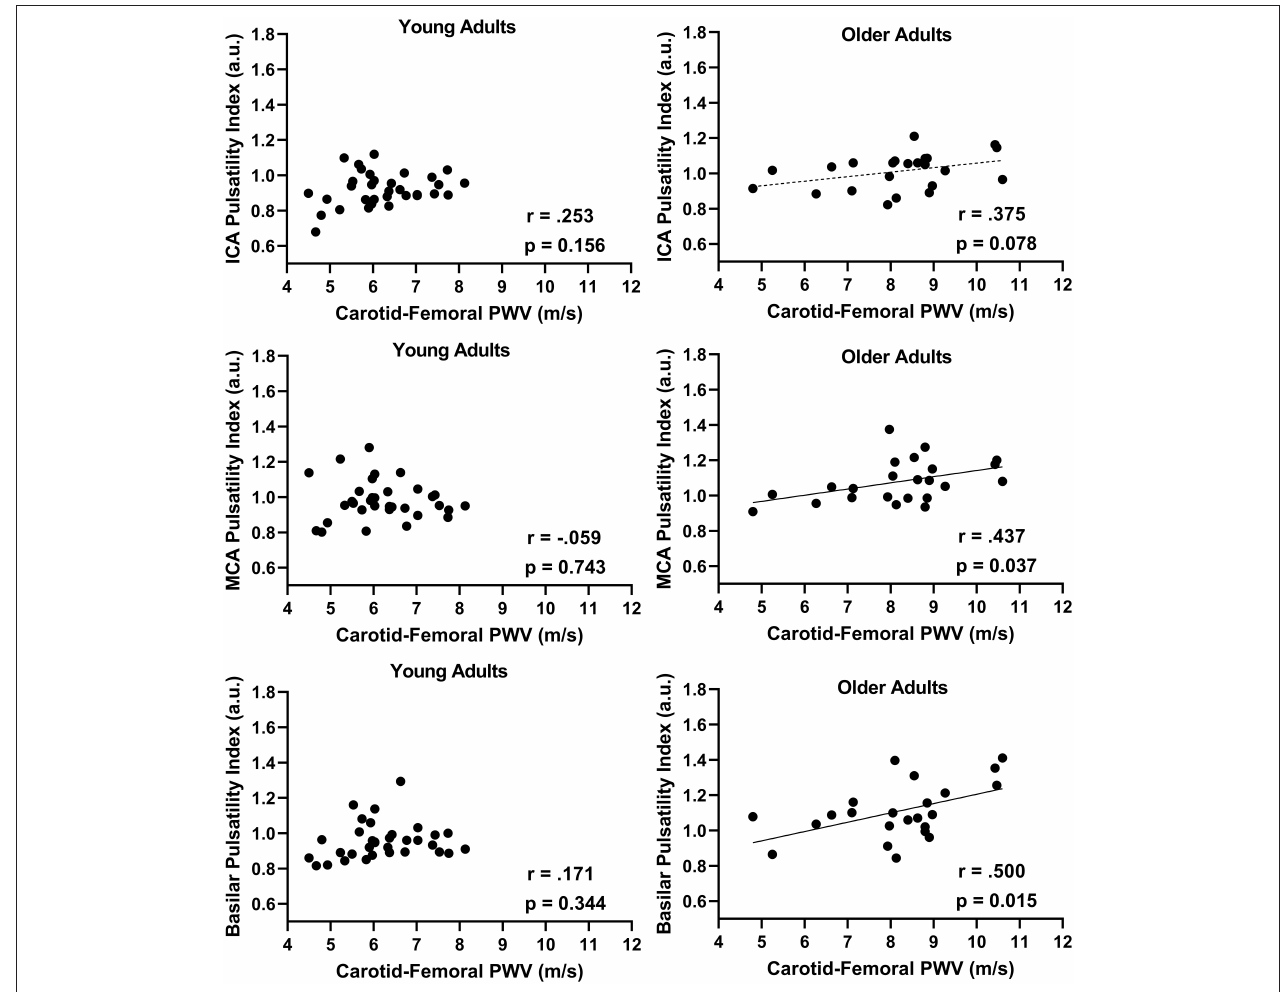
FIGURE 2 | The relationship between internal carotid artery (ICAs), middle cerebral artery (MCAs), and basilar artery pulsatility index with aortic stiffness (cfPWV) split by age groups, young adults ( N = 33) vs. older adults ( N = 23) using Pearson correlations.